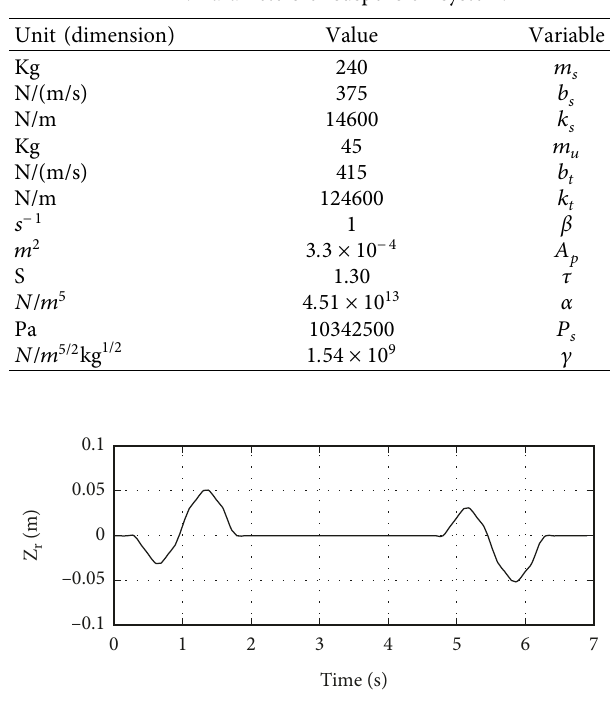
Figure 6: Terrain of the road